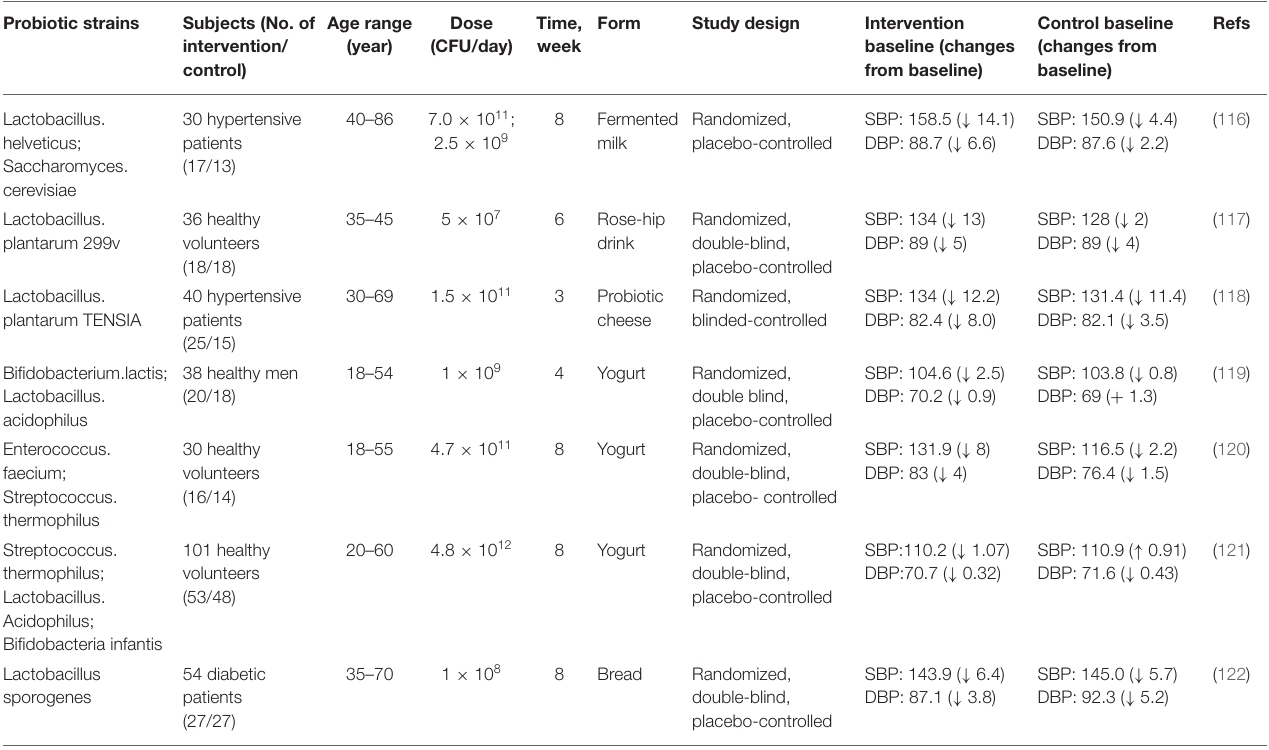
TABLE 2 | The effect of probiotics in the regulation of blood pressure. Probiotic strains Subjects (No. of